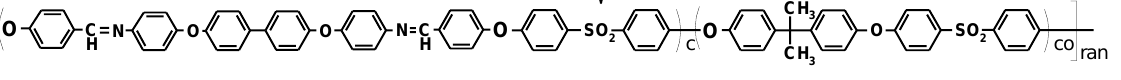
Figure 1. The structure of the poly(azomethine)s P1 – P4 . The difference among the four polymers was the different content of mesogenic units: P1 (100%); P2 (75%); P3 (50%); P4 (25%).